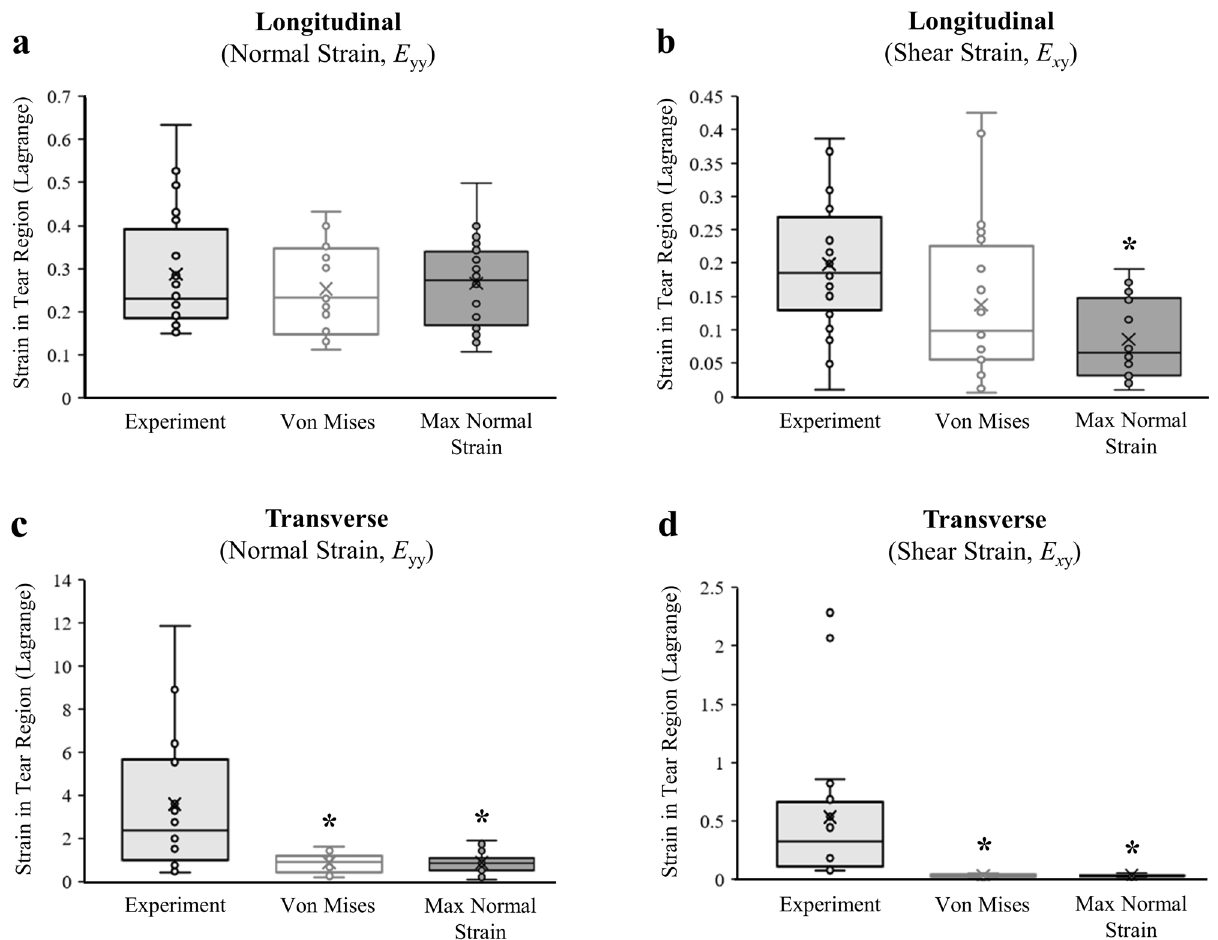
Figure 6:. Comparison of strains in the tear region (ROI) between experiments measured using DIC and FE models generated with von Mises stress or maximum normal strain damage criterion. ( a ) Both damage criteria gave close predictions to the normal axial strains for the longitudinal loading condition, but ( b ) the maximum normal strain damage criterion significantly underpredicted the shear strains. ( c ) When loading